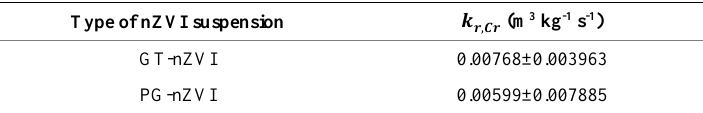
Table 6. Kinetics of Cr (VI) reduction by